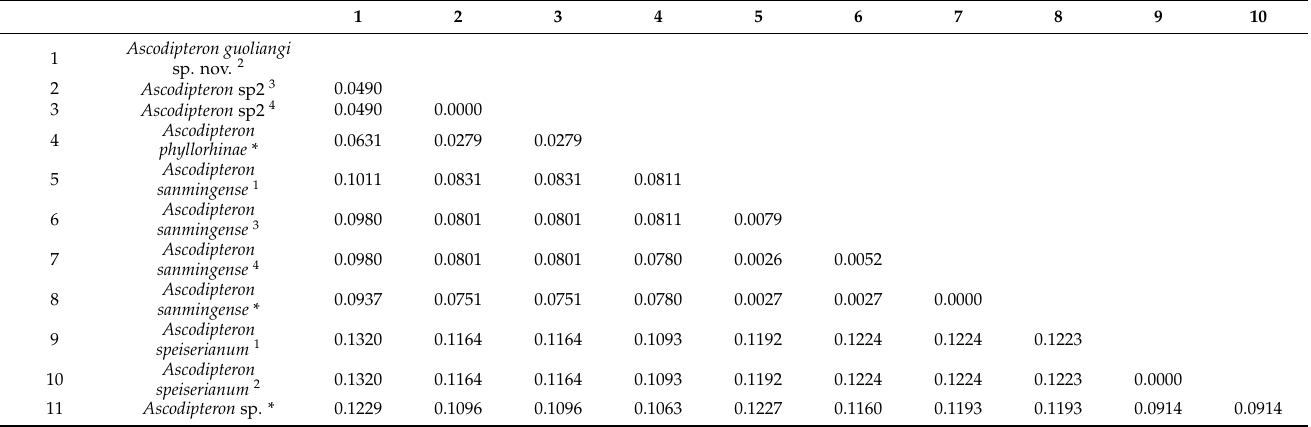
Table 2. Pairwise differences of mitochondrial cytochrome b gene ( Cytb ) sequences between species, based on Kimura 2-parameter. Numbers in column headers refer to species and populations listed in their respective rows. Superscript numbers behind binomial names indicate different specimens of the same species, from different hosts and/or habitats. Sequences downloaded from GenBank marked by asterisks. All specimens are neosomes obtained from a host except number 7, which is a male that emerged from